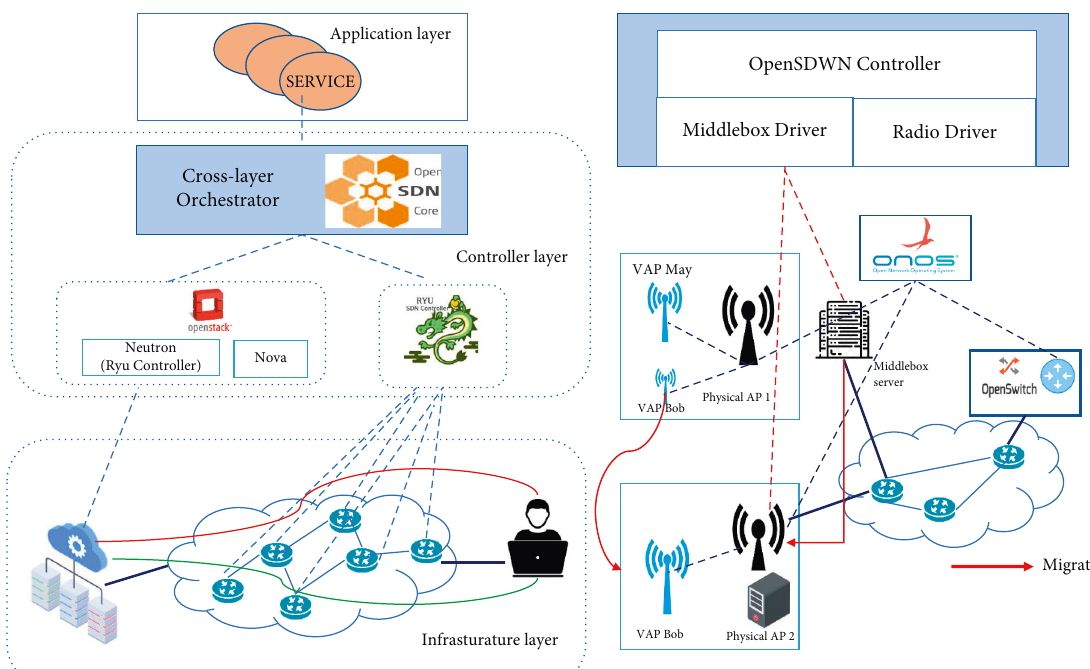
Figure 6: NFV/SDN architectures based on different applications